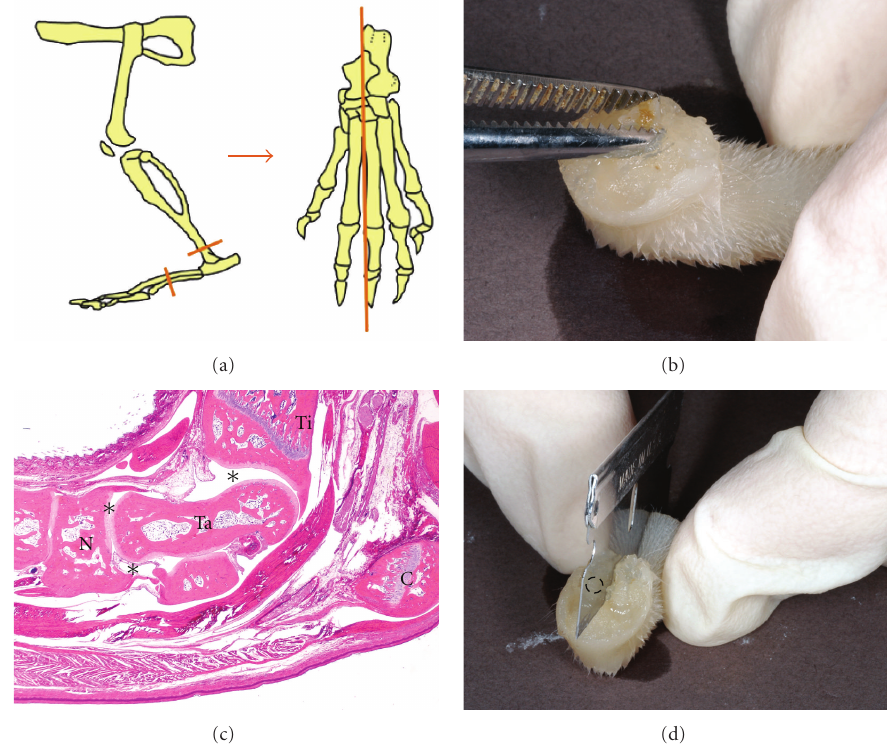
Figure 5: Tissue trimming procedure for reliable and reproducible production of high-quality hind paw sections for histopathological analysis of immune-mediated arthritis in rodents. A skeletal schematic diagram (a) shows the location of the cuts required to isolate the tibiotarsal region. As viewed from the lateral side (a (left panel)), the hind paw is separated from the distal limb just above the tibiotarsal (hock (or “ankle”)) region at the fur line, and the digits (toes) are removed. From the top (a (right panel)), the hind paw is divided longitudinally using a cut placed between metatarsals II and III, which will fall just to the outside of the talus (the uppermost bone to the left of the orange line) and tibia (the distal leg bone (not shown)) that articulates with the talus. The distal tibia ((b), bracketed by forceps) is identified at the proximal cut margin of isolated hind paws as an oval white bone with a yellow/brown core of bone marrow. The longitudinal dividing cut (d) is made from the dorsal side by engaging the blade at the proximal and distal margins of the sample and then cutting straight down; the dashed black oval indicates the position of the tibia behind the razor blade, indicating that the blade is located just to the side of this bone. The microscopic structure of hind paw sections taken through this region from a nonarthritic rat (c) will include the joint spaces most susceptible to induced models of immune-mediated arthritis (asterisks ( ∗ )) as well as the most a ff ected tarsal bones (navicular (N) and talus (Ta)), the distal tibia (Ti), and sometimes the calcaneus (C (or “heel”)). Histologic stain: hematoxylin and eosin